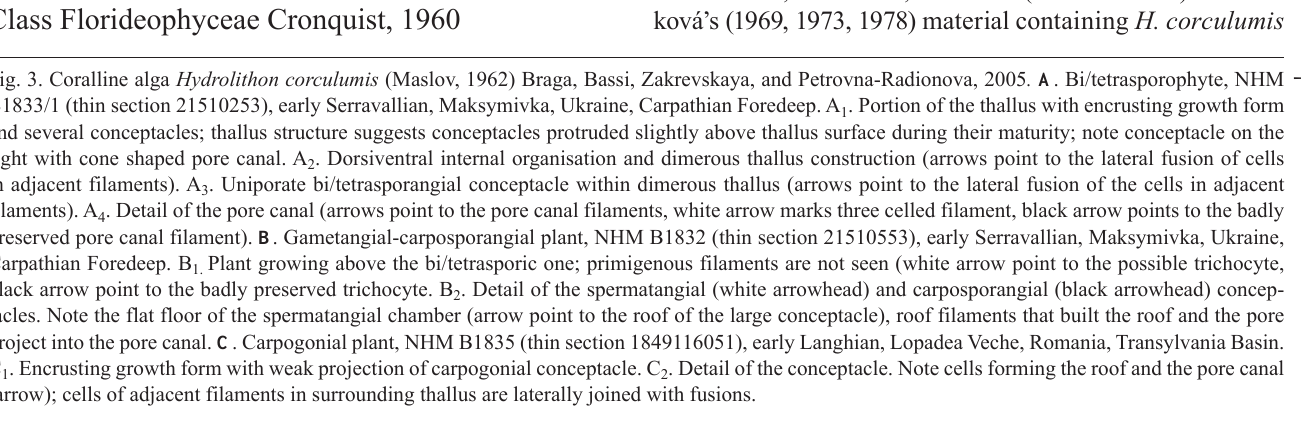
Fig. 3. Coralline alga Hydrolithon corculumis (Maslov, 1962) Braga, Bassi, Zakrevskaya, and Petrovna-Radionova, 2005 . A . Bi/tetrasporophyte, NHM B1833/1 (thin section 21510253), early Serravallian, Maksymivka, Ukraine, Carpathian Foredeep. A 1 . Portion of the thallus with encrusting growth